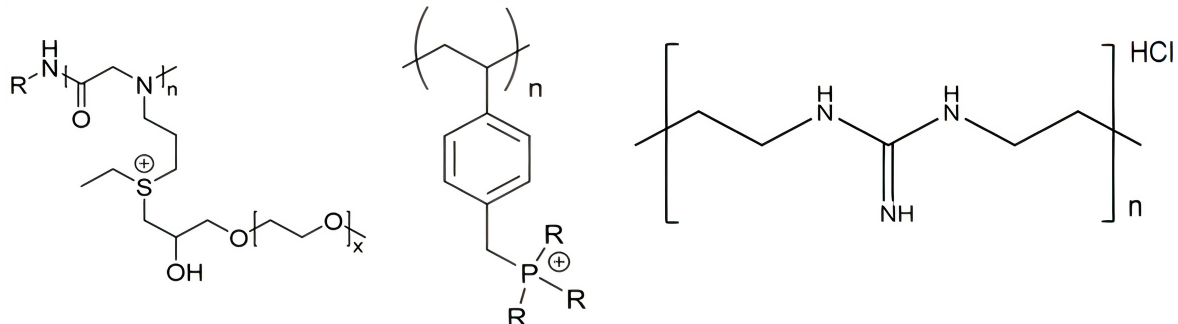
Figure 9. From left to right, some cationic polymers with different cationic moieties such as sulfonium [139,140], phosphonium [142], and guanidinium [141,144].